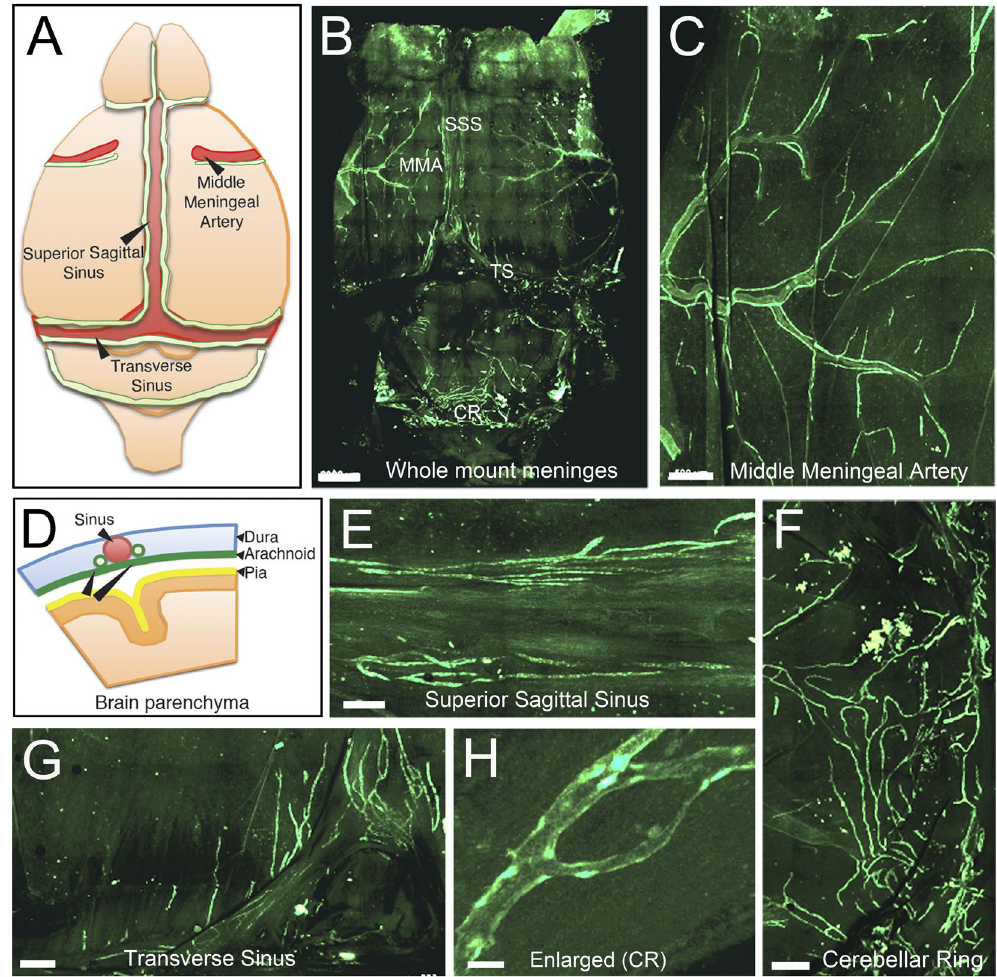
Figure 2. Visualization of meningeal lymphatic vessels in Prox1-EGFP rat. Meninges from Prox1-EGFP rats were dissected and imaged as a whole mount. ( A ) Simplified diagram showing the lymphatics (green) positioned along the veins (superior sagittal and transverse sinuses) and artery (middle meningeal artery) of the rodent meninges. ( B ) Overview of whole mount meninges. SSS : Superior Sagittal Sinus, TS : Transverse Sinus, MMA : Middle Meningeal Artery, CR : Cerebellar Ring. ( C ) Lymphatic vessels were easily detected in the area of the middle meningeal artery. ( D ) Scheme of the meninges anatomy. The pia is localized on top of the brain parenchyma, the dura mater lines the skull, and the arachnoid matter lies between the pia and dura mater. The meningeal lymphatics are localized within the dura matter along the sinuses. Lymphatics were also clearly detectable in superior sagittal sinus ( E ), cerebellar ring ( F ), and transverse sinus ( G ). ( H ) Lymphatics in the cerebellar ring are enlarged in panel ( F ). Scale bars: 2 mm ( B ), 500 µ m ( C,F,G ), 300 µ m ( E ), 30 µ m ( H